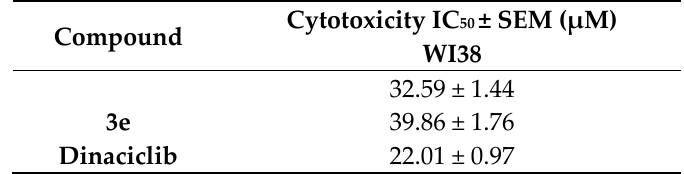
Table 4. Antiproliferative IC 50 ± SEM ( μ M) activity of compounds 3c , 3e, and